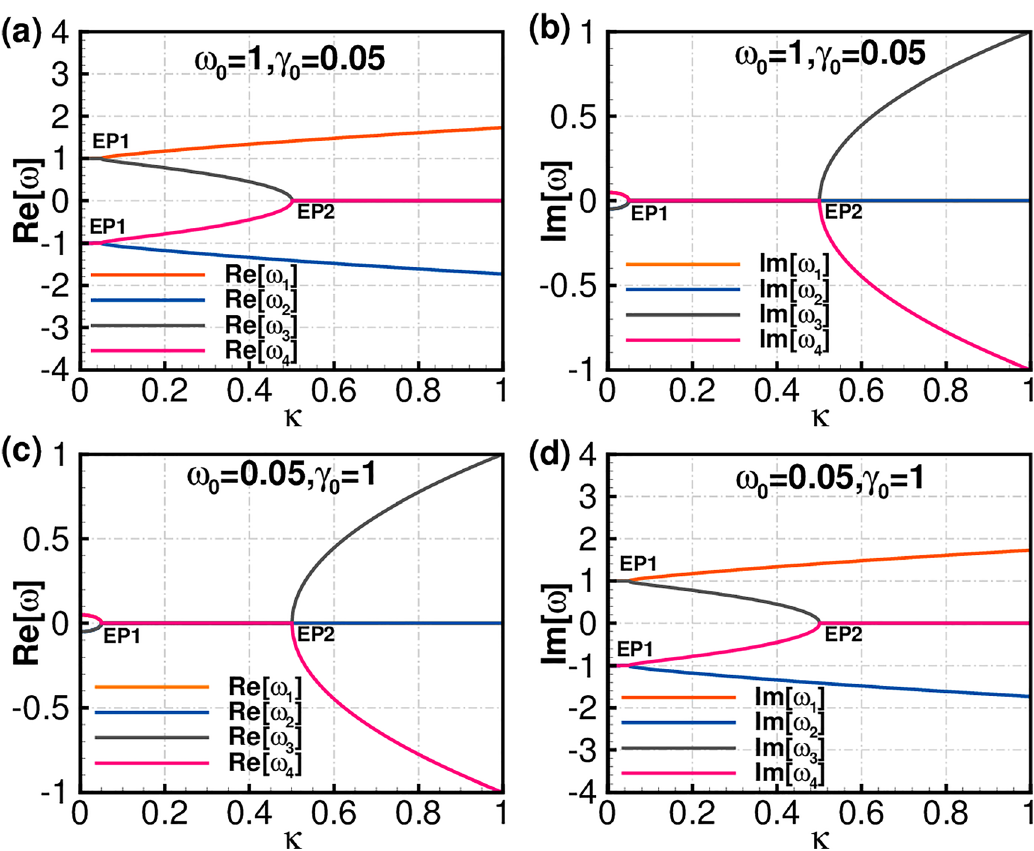
Figure 2: Eigenfrequencies and exceptional points. (a) The real part of the eigenfrequencies for ω 0 = 1 , γ